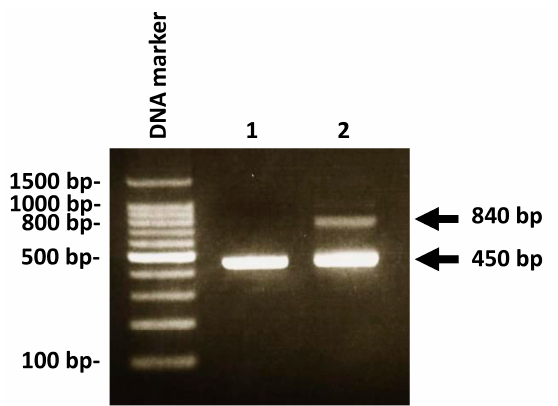
Figure 1. Polymerase chain reaction (PCR) detection of group I intron insertion in C. albicans positive cases. Lane 1: PCR products of 450 bp alone were found. Lane 2: PCR products of 450 bp and 840 bp were found. PCR products of 840 bp indicate the insertion of an intron into C. albicans DNA. Table 2. Relationship between intron insertion of C. albicans and clinical factors in C. albicans -posi- tive participants.